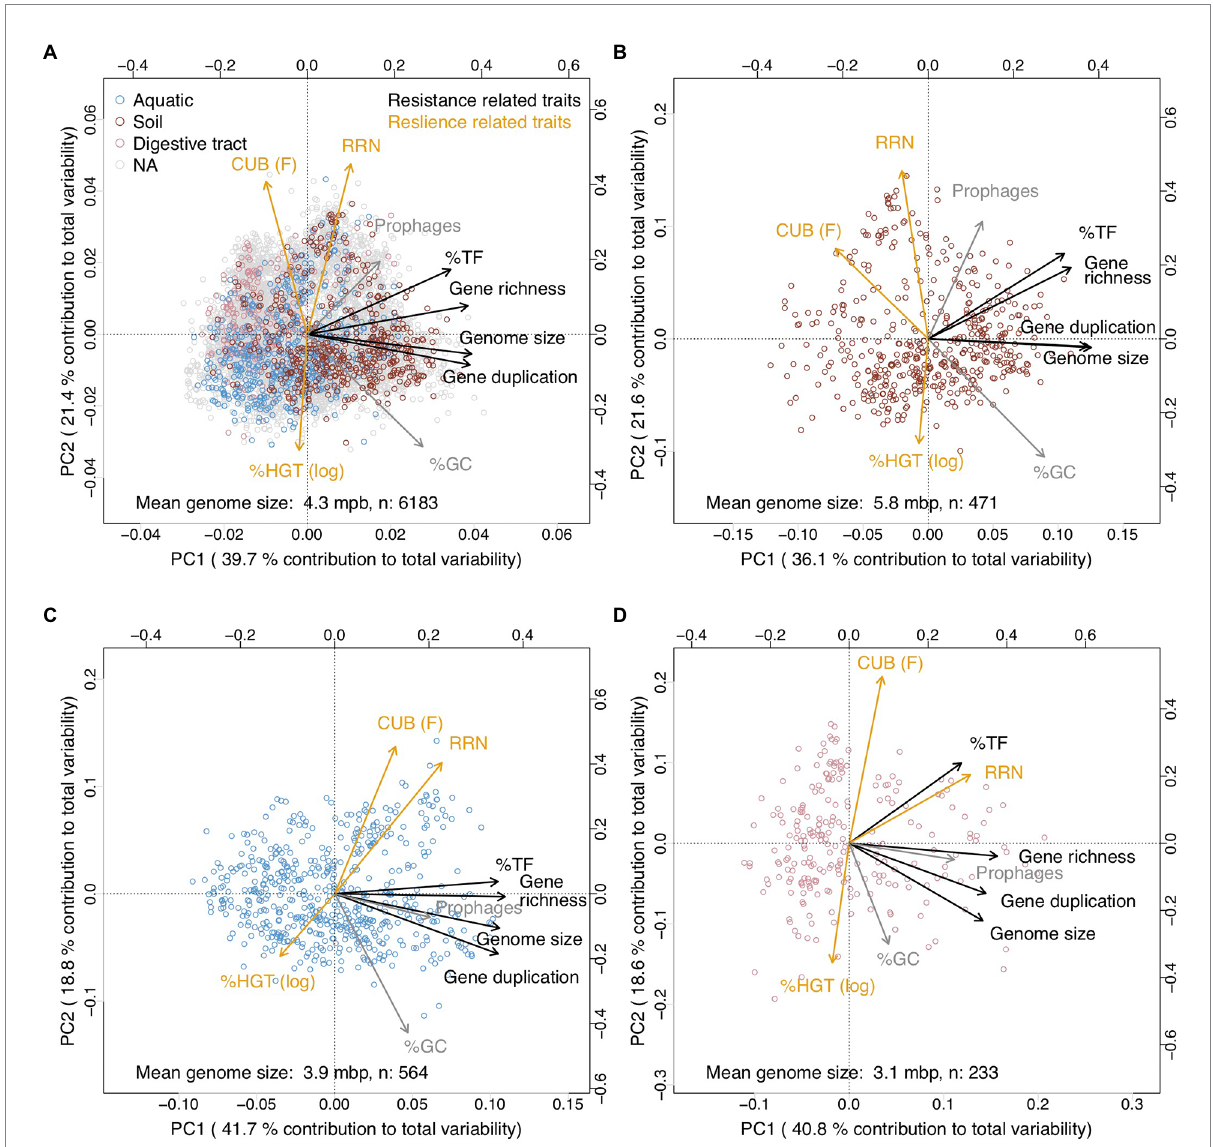
FIGURE 6 Principal component analyzes illustrating covariations among genomic traits from 17,856 JGI/IMG prokaryotic genomes in dependence on the habitat type. The genomes were after assignment to the habitat type aggregated at the species level. Traits assigned in this study as resistance and resilience traits were colored in black and orange, respectively. %GC and prophages that were not assigned in this study to either resistance or resilience related traits were colored in gray. (A) All genomes. (B) Genomes originating from soil habitats. (C) Genomes originating from aquatic habitats. (D) Genomes originating from the digestive tract. The three habitat types were determined via text search from the habitat information available via the JGI/IMG database: all genomes containing the strings ‘soil’ or ‘rhizosphere’ in the habitat description where classified as originating from soil habitats; all genomes containing the strings ‘aquatic’ or ‘marine’ or ‘water’ where classified as originating from aquatic habitats; all genomes containing the strings ‘oral’ or ‘stomach’ or ‘gut’ or ‘intestinal’ or ‘feces’ were classified as originating from the intestinal tract. The remaining genomes were not further